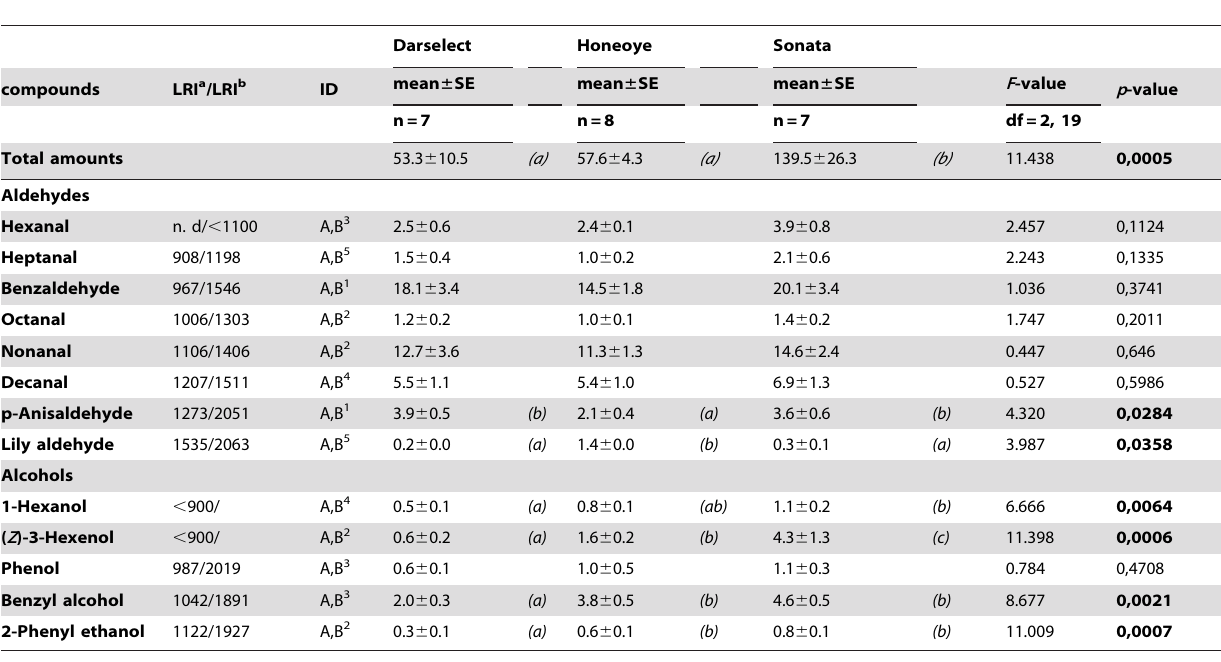
Trace indicates average amount less than 0.1 ng g 2 1 flowers. Bold font indicates significant p- values for the calculated model (glm). Different lower-case letters indicate significant pairwise differences between respective means of different strawberry varieties at p , 0.05 (Tukey test). *: Stereochemistry not determined. Linear retention indices (LRI) were calculated from chromatograms obtained with a HP-5MS (LRI a ) and an HP-INNOWax (LRI b ) column. Identification (ID) is based upon mass spectrum matched with those of databases (Wiley 09, Nist 08, and Hochmuth, 2004). LRI is confirmed by synthetic standards. Source of synthetic standards: 1 Fluka (Germany), 2 Merck-Suchardt (Hohenbrunn, Germany), 3 Aldrich (Germany), 4 Acros (Germany), 5 Sigma-Aldrich (Steinheim, Germany), 6 TCI (Zwijndrecht, Belgium). n. d.=non detec-